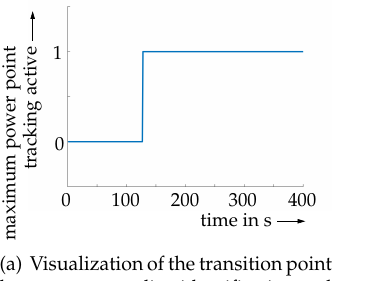
(b) Estimation accuracy of the optimum electric current I k + 1 in Equation (35).